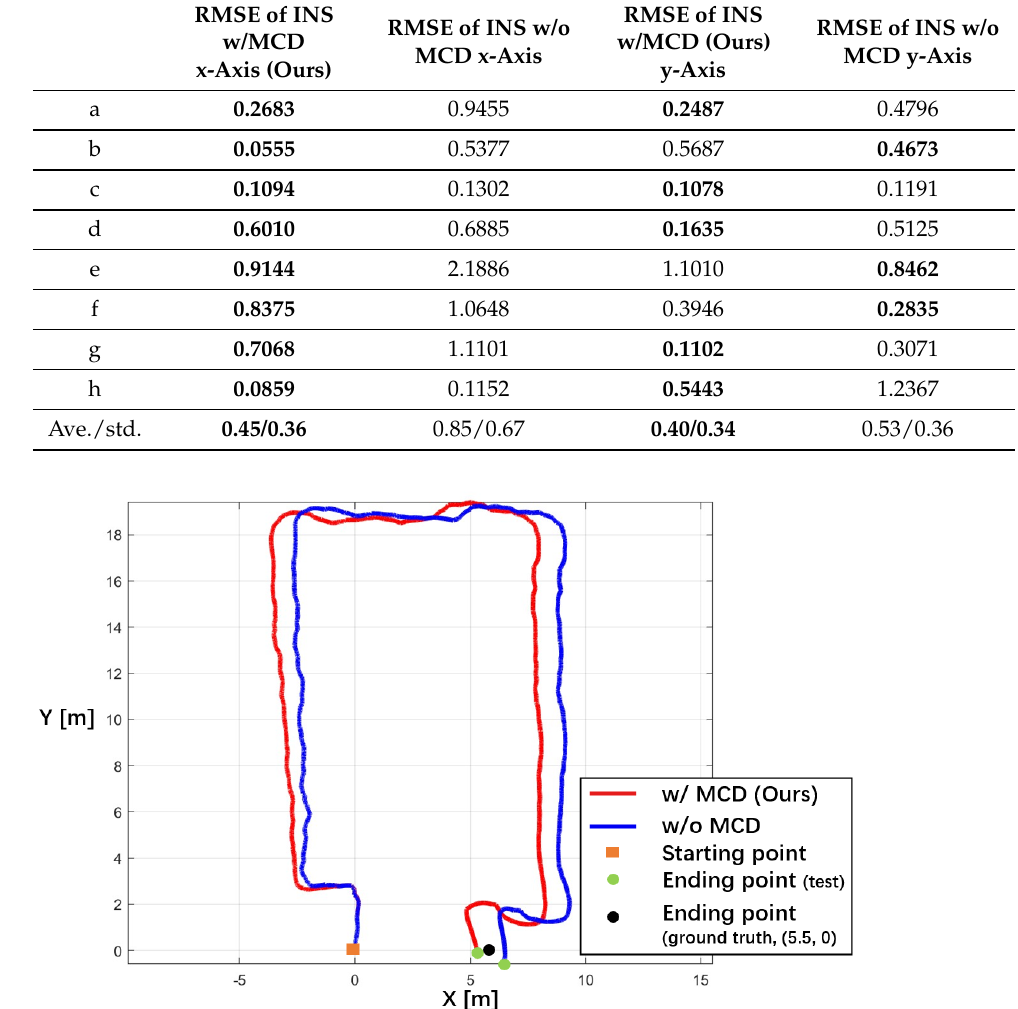
Figure 12. 2D plotting of the fused trajectory with MCD (red line) and without MCD (blue line) of Scenario 3 participant